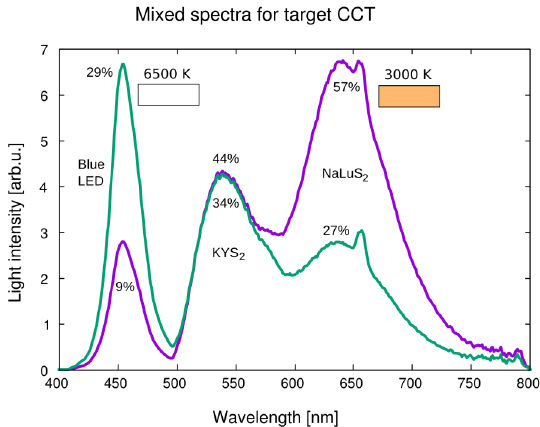
Figure 14. Commission Internationale de I’Eclairage (CIE) 1931 color coordinates calculated for samples under ~390 nm excitation (dark points, labeled inside) and ~450 nm excitation (empty diamonds, labeled outside)—Actual excitation is written below each sample label. Blue light emitting diode (LED) at 460 nm added for comparison. Lines denote colors available by mixing multiple materials under 390 nm and 455 nm excitation, respectively.